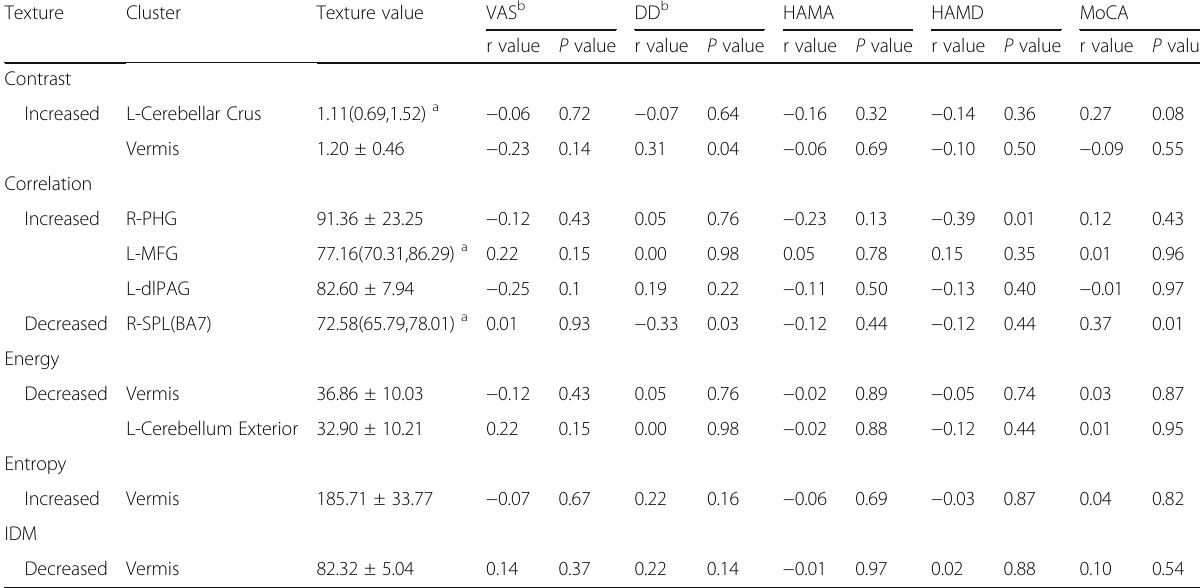
Table 3 Correlation analysis between positive clusters ’ texture value and clinical variables in MOH Texture Cluster